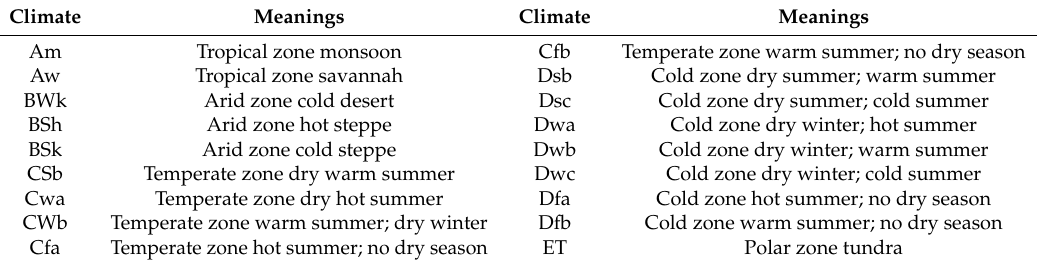
Table 2. The meaning of Koppen–Geiger climate classification.